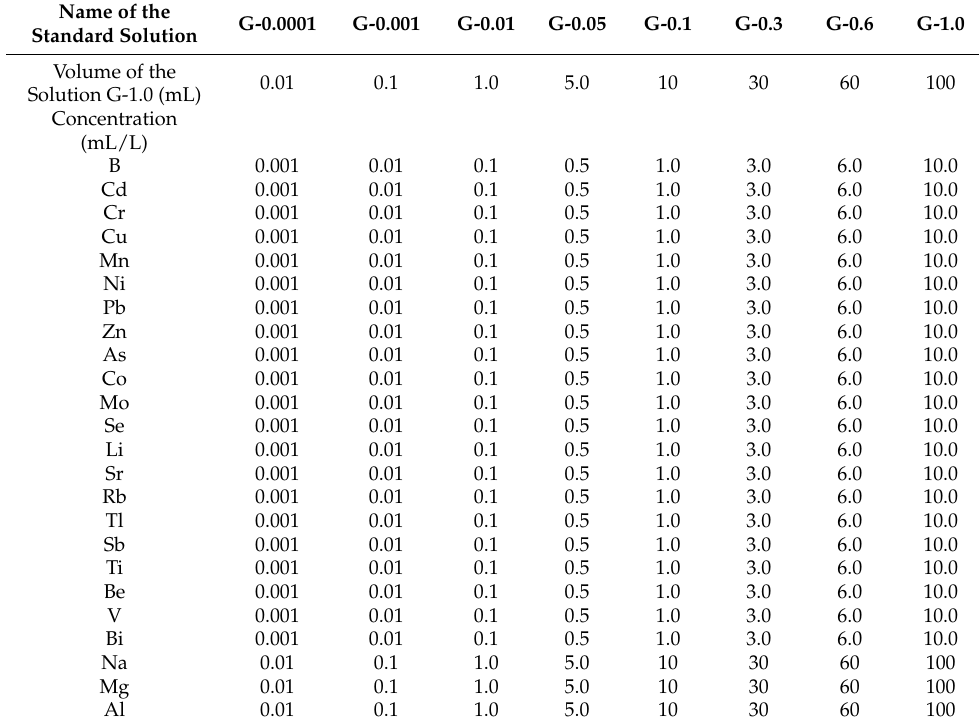
Table 1. Concentrations of multi-element standard commercial